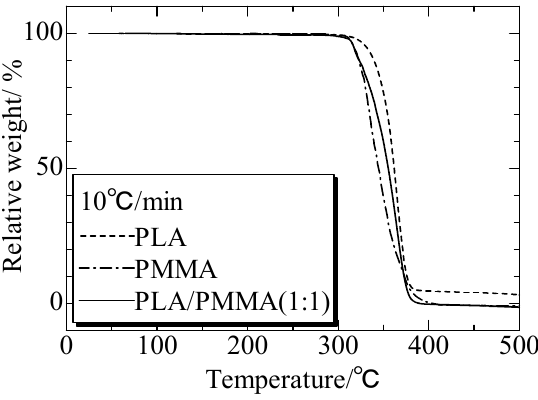
Figure 20. TG analysis of PLA, PMMA, and PLA / PMMA blends of 1:1. Adapted from Reference [151].